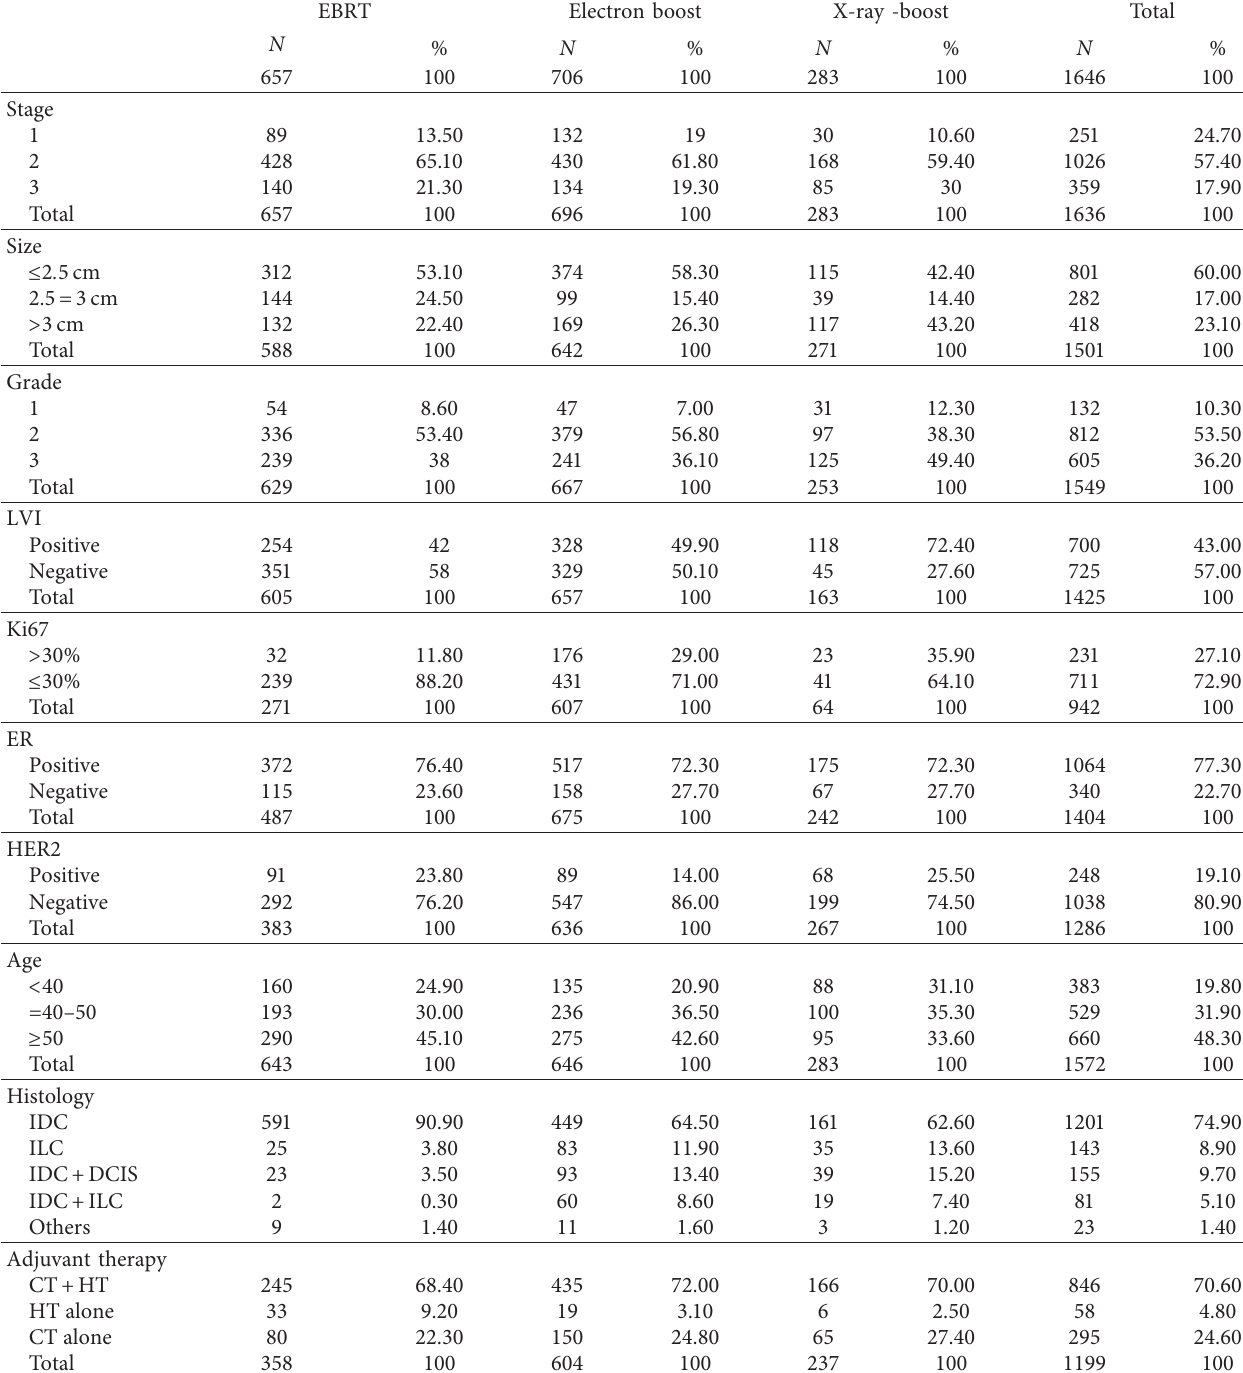
Table 2: Clinical, pathologic, and treatment-related characteristics of the EBRT and boost-IORT groups. EBRT Electron